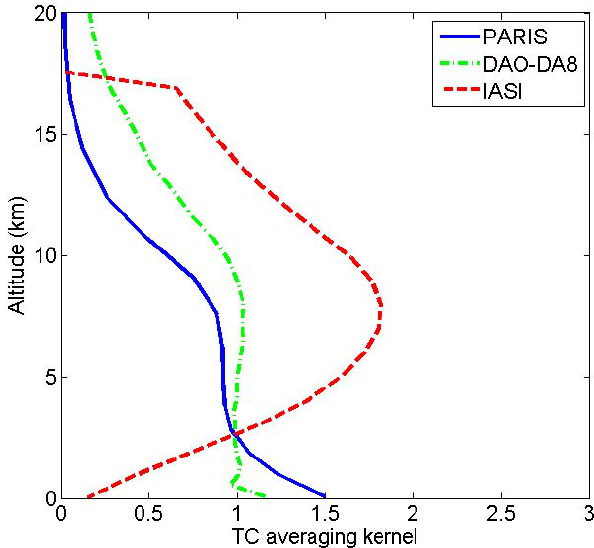
Fig. 1. Typical total column (TC) averaging kernels for CO for PARIS-IR (solid blue line), DA8 (dot-dashed green line) and IASI during a morning overpass (dashed red